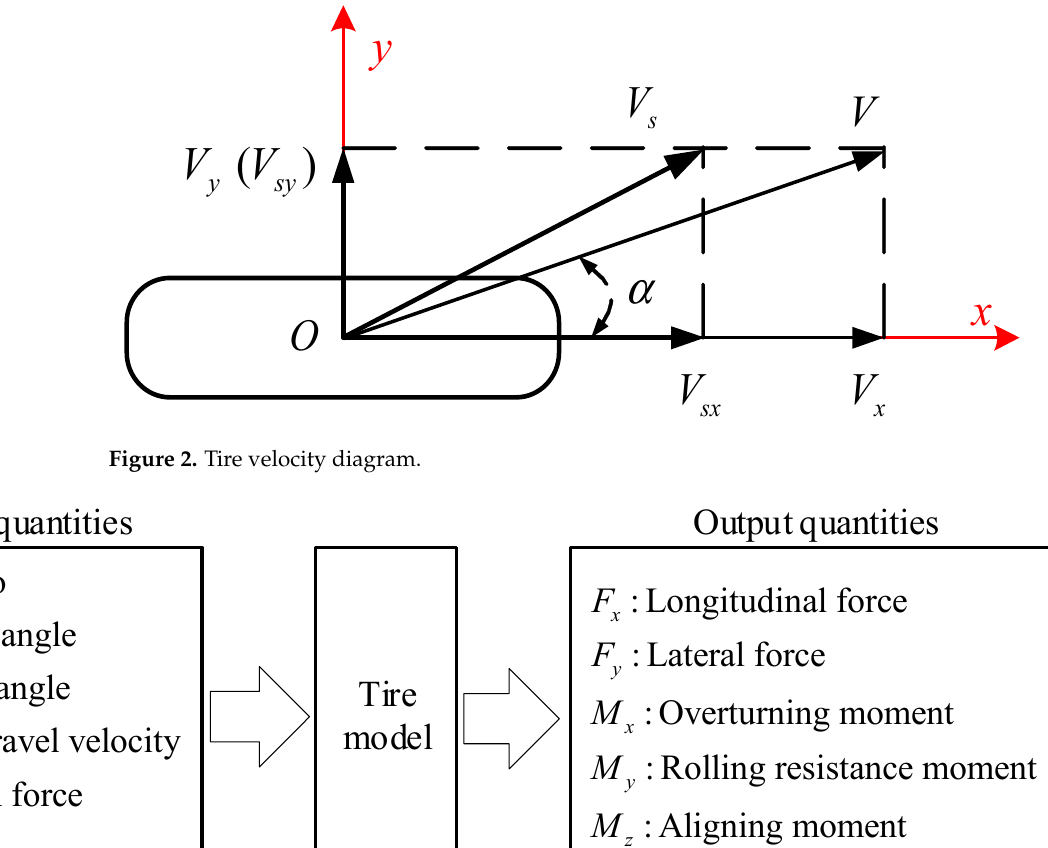
precision and a uniform form. It is also suitable for motorcycle tires with a large camber angle [19,20]. This study uses Magic Formula PAC2012 to establish the tire model. Figure 2. Tire velocity diagram.